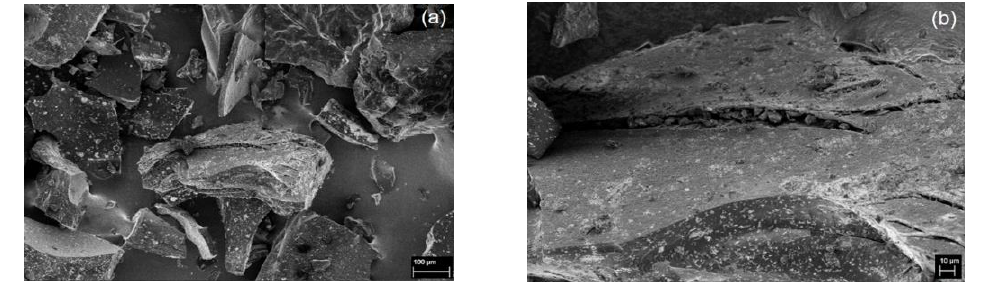
Figure 2. SEM images of CCF at ( a ) 250× and ( b ) 1000× magnification.